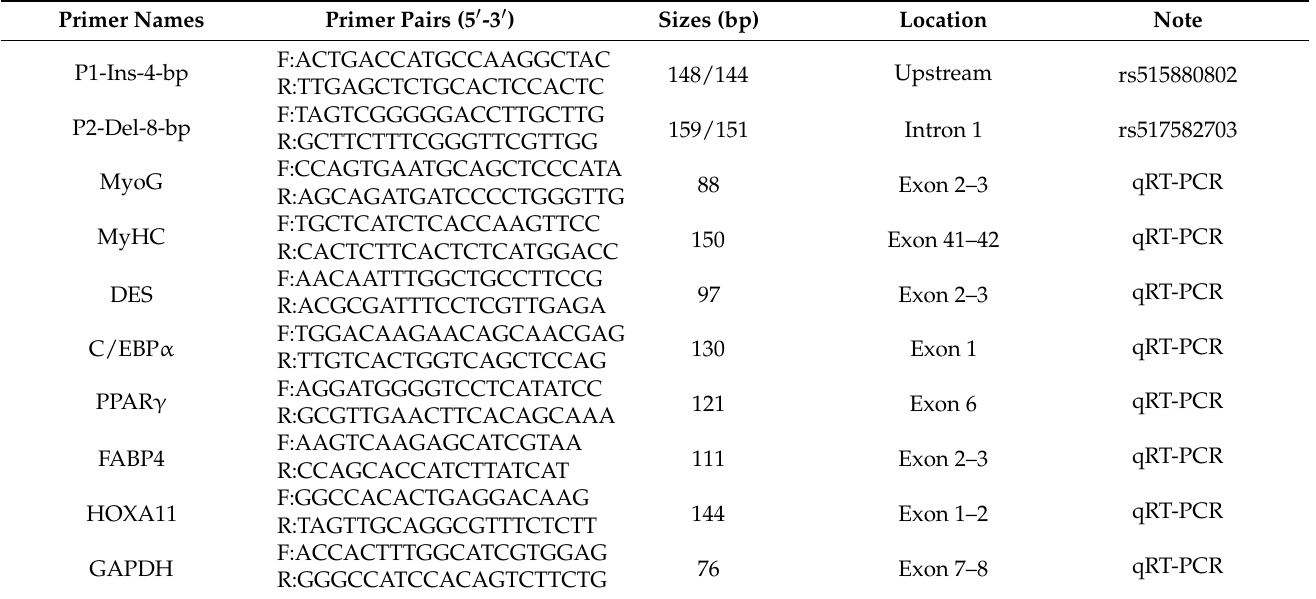
Table 1. Primers used in this